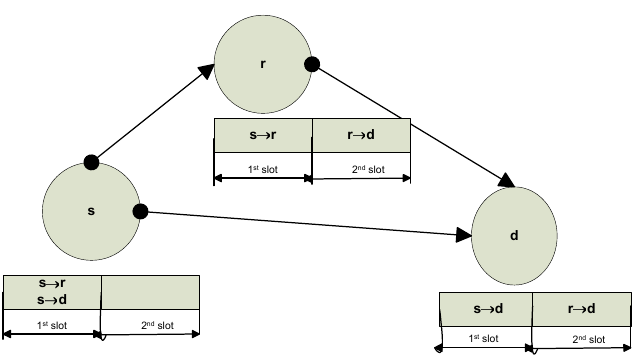
Figure 1. Cooperative transmission